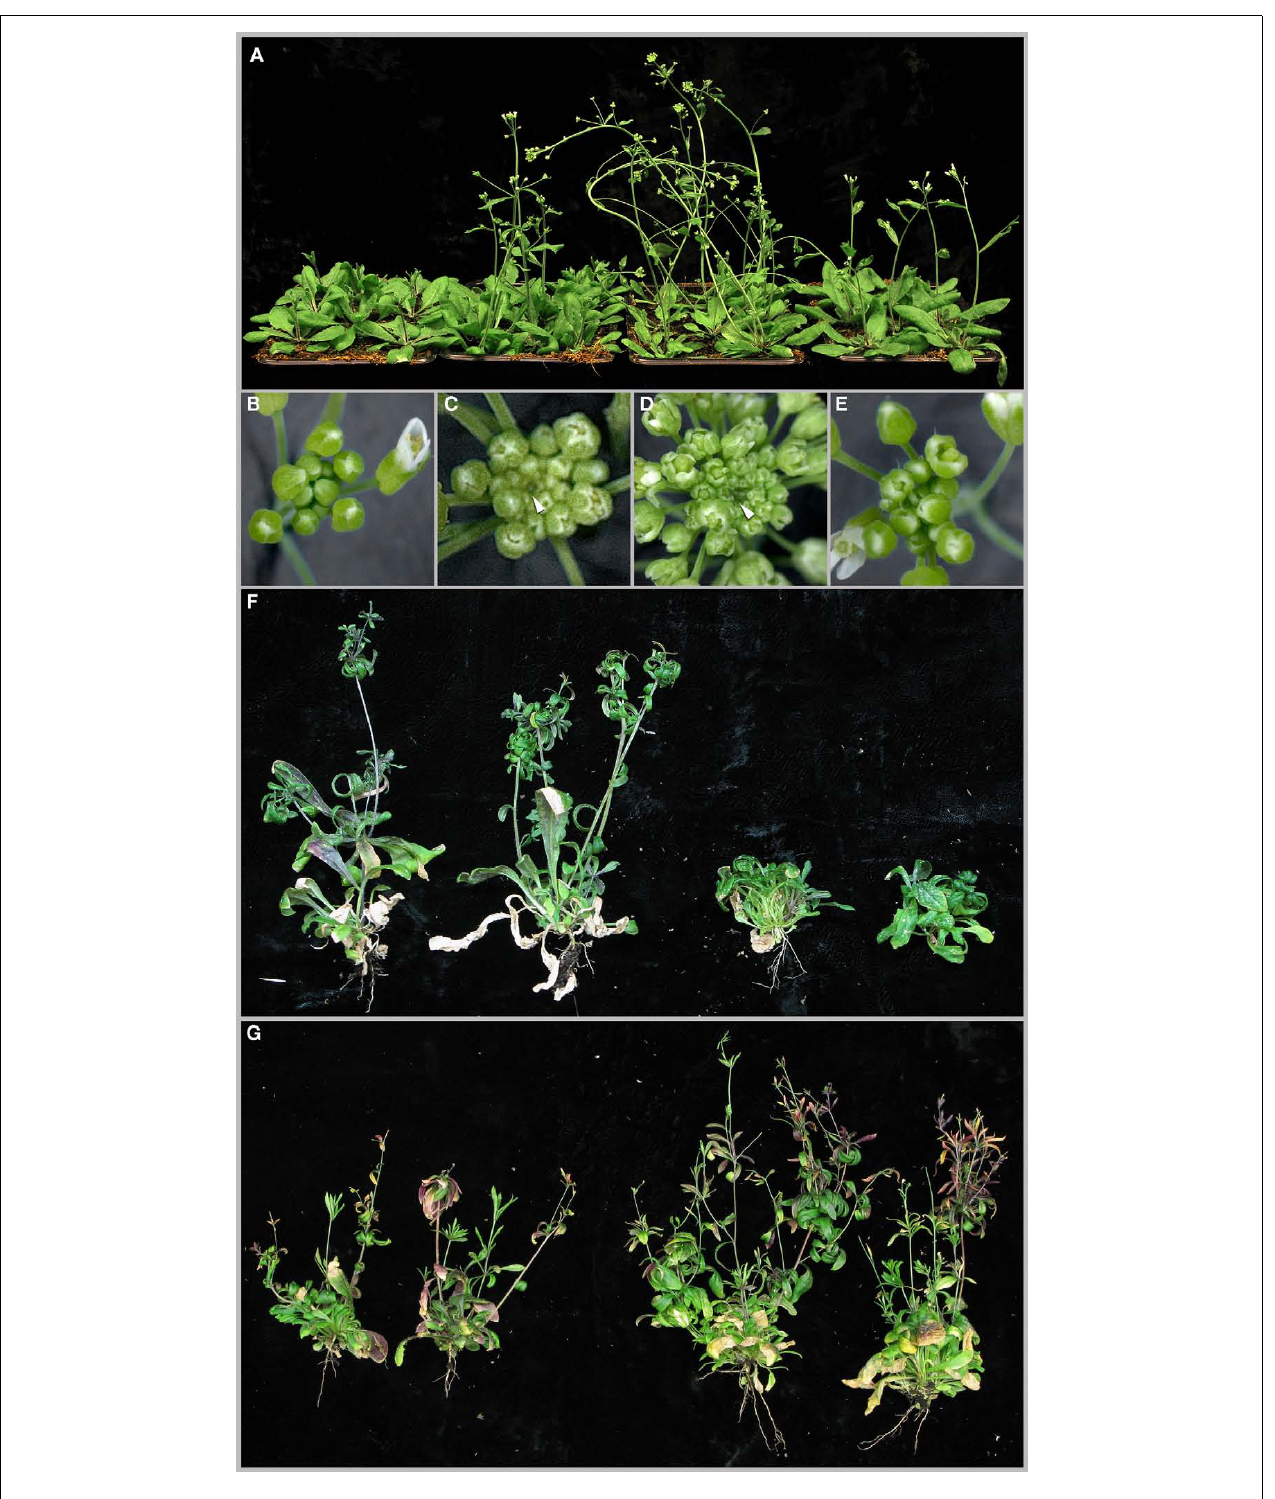
inhibition of shoot outgrowth in the double mutant. At later developmental stages a reduced number of shoots grows at a slow rate. (G) Two stm mutants (left) and two pan stm double mutant plants (right). Note the elevated number of shoots and branches, as well as floral buds in the pan stm double